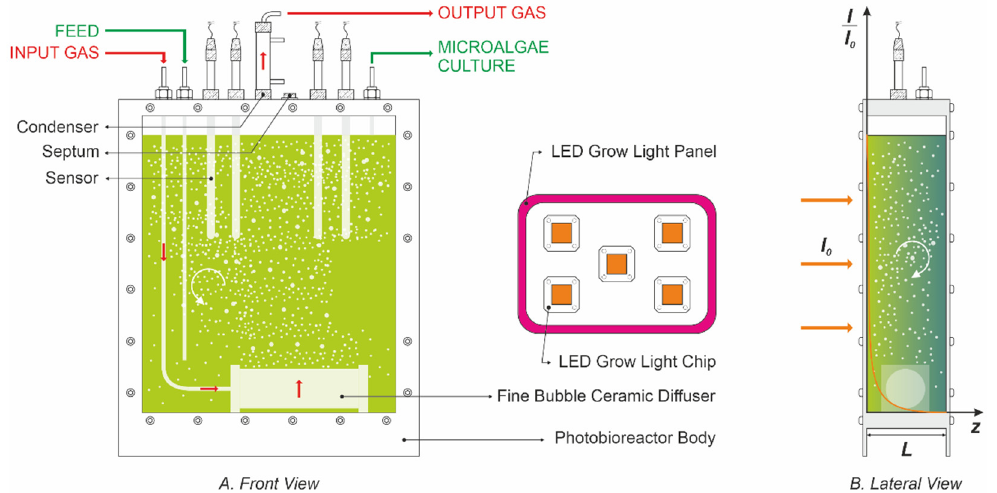
Figure 2. ( A ). Front view of an airlift PBR with a LED growth light panel and their main components [37]. ( B ). The lateral view of the PRB showing the attenuation of the light inside the microalgae